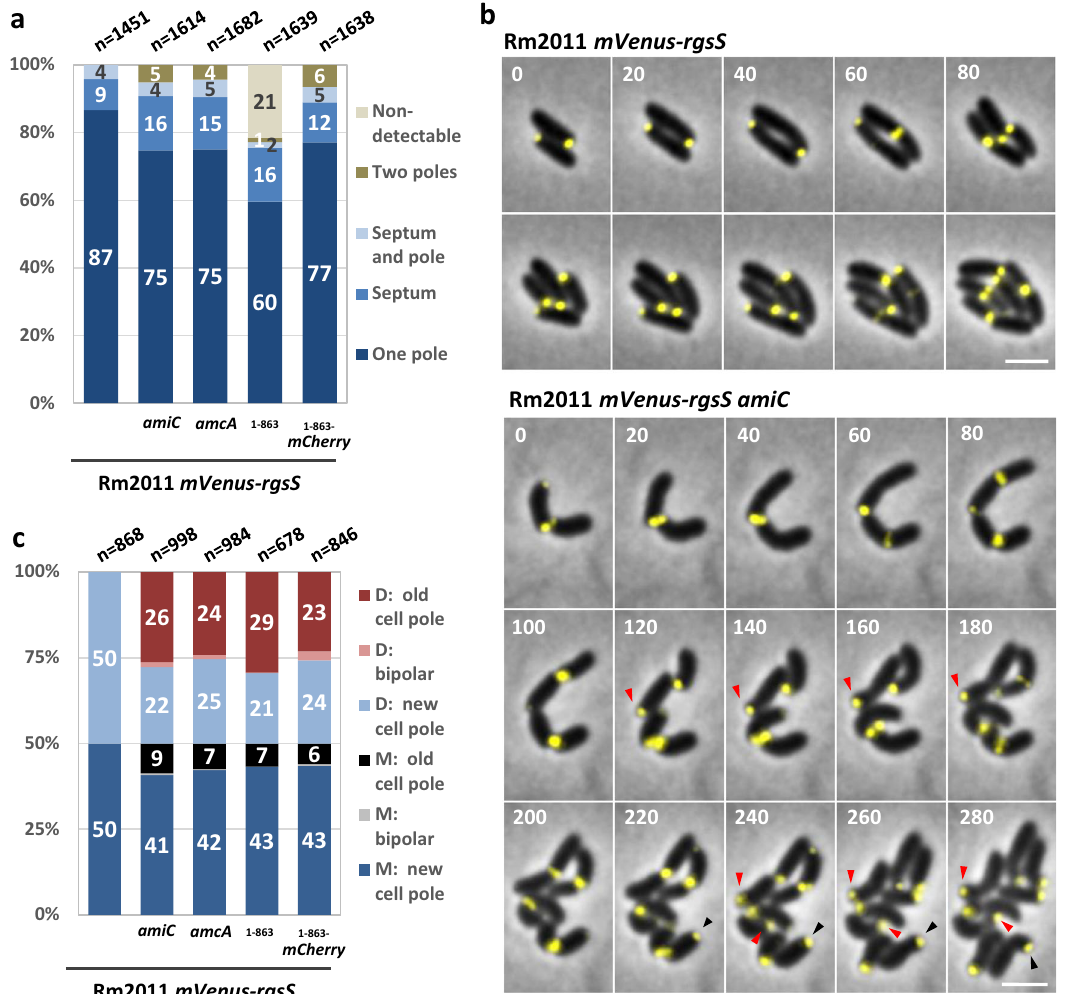
Fig. 2 AmiC, AmcA, and the SPOR RgsS are required for stable inheritance of RgsS to the newly formed cell poles after cell division. a mVenus-RgsS localization patterns in cells from exponential phase TY cultures. n, total number of analyzed cells. The values represent the mean values of three biological replicates. The standard deviation values and statistical comparison between the strains are shown in Supplementary Table 3. b Time lapse microscopy images of Rm2011 mVenus-rgsS and its amiC mutant derivative, growing on MM-agarose. Merged mVenus fl uorescence and phase contrast pictures are shown. Red and black arrowheads point to cells with localization of mVenus-RgsS foci to old cell poles of the daughter and the mother cells, respectively. Time is shown in minutes. Scale bar, 2 µ m. The images are representative of three independent cultivations and microscopy analyses. c mVenus-RgsS foci inheritance observed in time-lapse microscopy. D daughter cell, M mother cell. n total number of analyzed cells. The values represent the mean values of three biological replicates. The standard deviation values and statistic comparison between the strains are shown in Supplementary Table